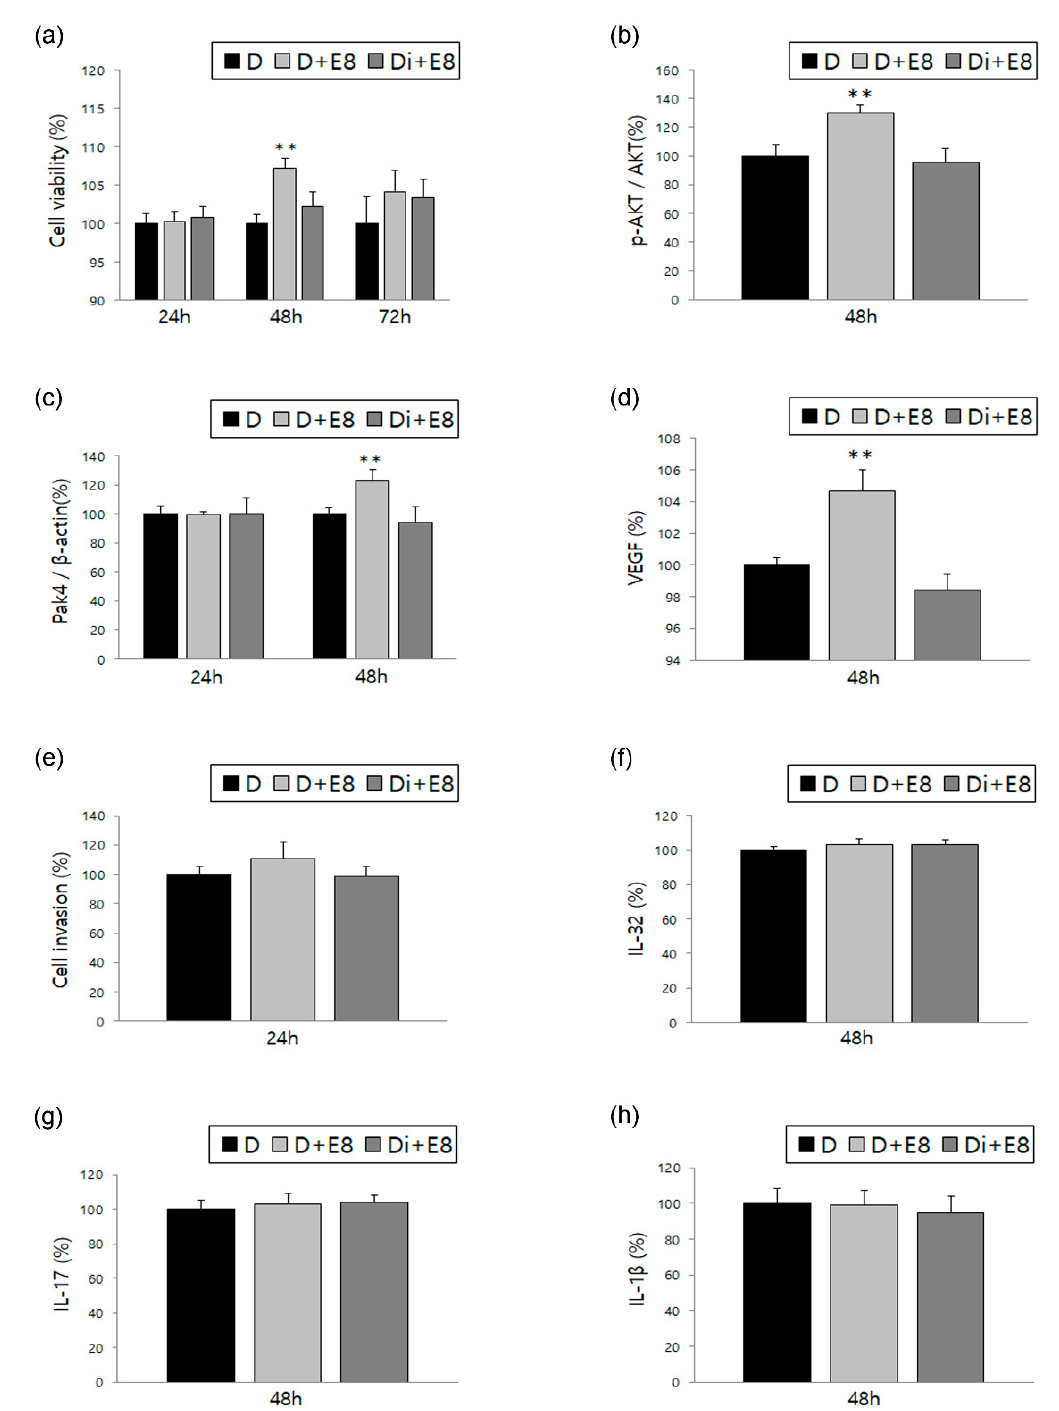
Figure 1. Effect of dienogest (DNG) and estradiol on human endometrial stromal cells (ESCs). Time-dependent variation evaluated in the three groups for the following factors: ( a ) cell viability, ( b ) AKT phosphorylation, ( c ) Pak4 expression, ( d ) VEGF expression, ( e ) cell invasion, ( f ) IL-32 expression, ( g ) IL-17 expression, and ( h ) IL-1 β . Error bars show the mean ± standard error of mean (SEM). ** p < 0.05 versus control as well as treatment with both DNG and estradiol in ESCs. D = ESCs in dimethyl sulfoxide solution (DMSO; control); D + E8 = treated with estradiol 10 − 8 M; Di + E8 = treated with DNG 10 − 6 M and estradiol 10 − 8 M. Data are expressed as a percentage, wherein cells treated with the vehicle are normalized to